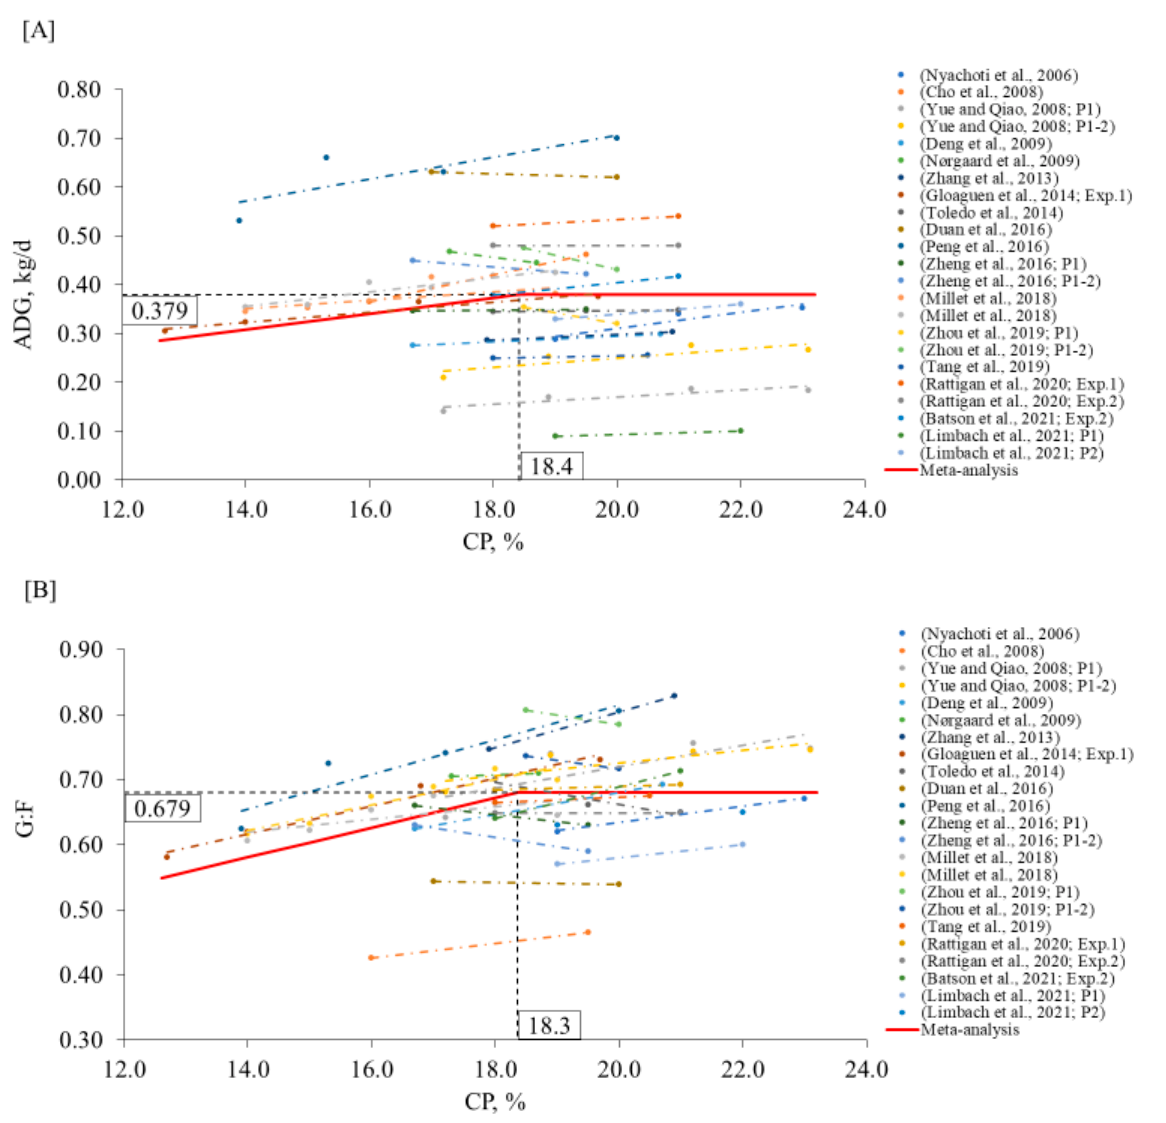
Figure 1. Changes in ADG ( A ) and G:F ( B ) in response to dietary CP in the nursery phase using a broken-line analysis. The equation for ADG was ADG = 0.379 − 0.016 × zl (R 2 = 0.98) and the breakpoint was CP level at 18.4% (95% CI: 16.3–18.4) when ADG was 0.379 kg/d. The p -value for the asymptote was <0.001, for the slope it was <0.001, and for the breaking point it was <0.001. The equation for G:F was G:F = 0.679 − 0.023 × z1 (R 2 = 0.91) and breakpoint was CP level at 18.3% (95% CI: 17.4–19.2) when G:F was 0.679. The p -value for the asymptote was <0.001, for the slope it was <0.001, and for the breaking point it was <0.001. Where, if CP is ≥ breakpoint, then z1 = 0; if CP Table 1. Summary of the studies included in the meta ‐ analysis to estimate changes in average daily gain and gain to feed in the nursery phase.